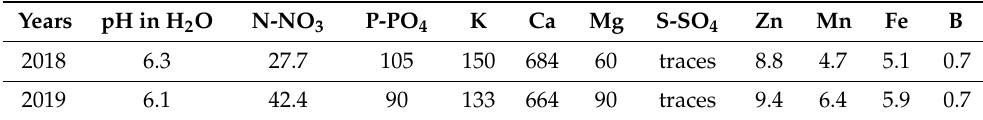
Table 1. The chemical composition of the soil before planting garlic (in mg dm − 3 , except for soil pH).